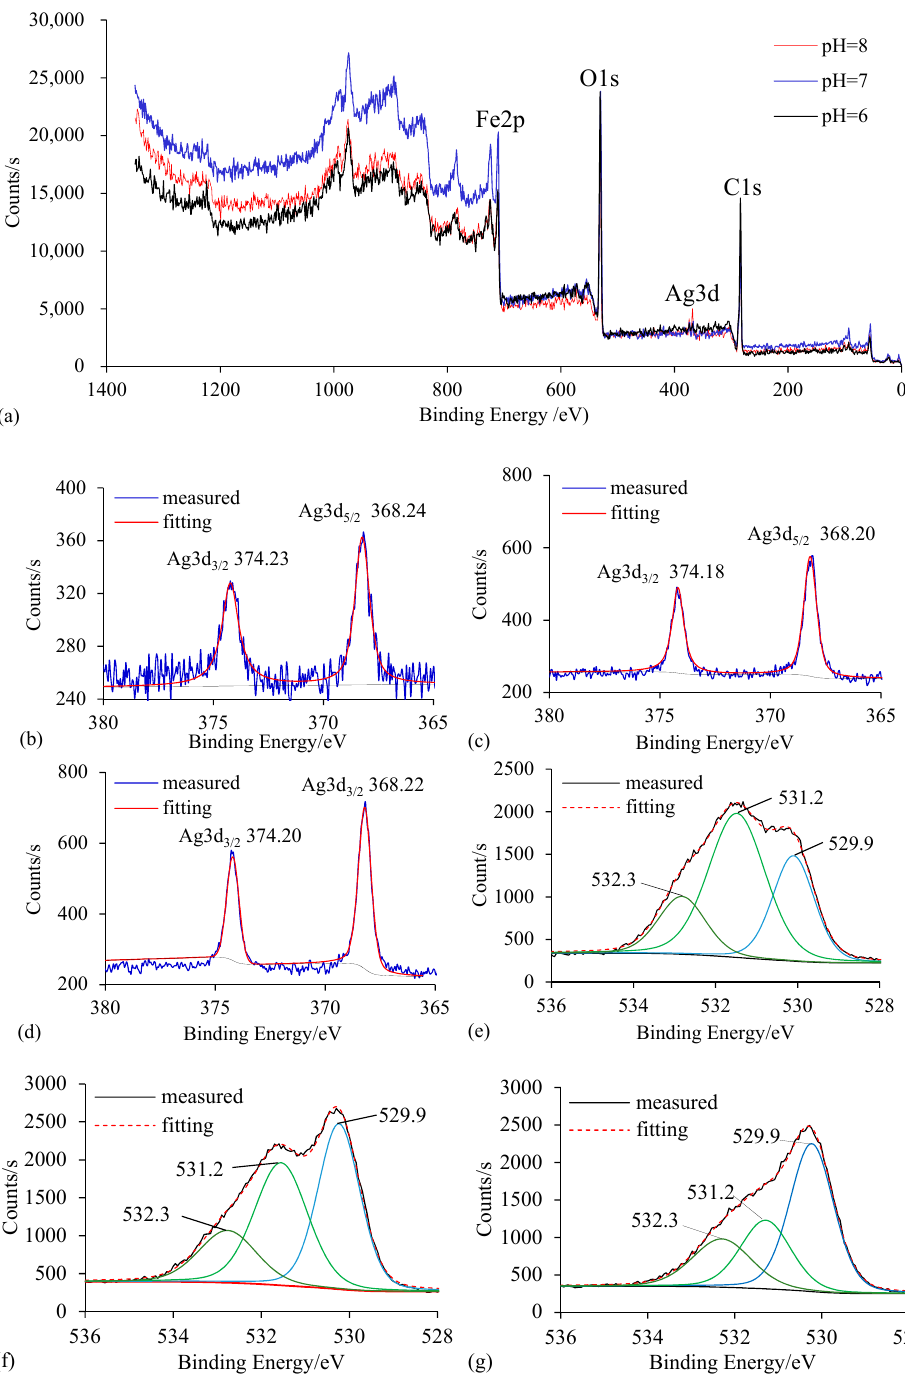
Figure 10. XPS wide-scan and high-resolution spectra of 0.4 wt.% Ag/Fe after reacting with 20 mg/L CCl 4 solution at initial pH of 6, 7 and 8. ( a ) Wide scan spectra of Ag/Fe; ( b – d ) Ag 3d core level XPS spectra of Ag/Fe at pH of 6, 7 and 8 respectively; ( e – g ) O1s core level XPS spectra of Ag/Fe at pH of 6, 7 and 8 respectively.